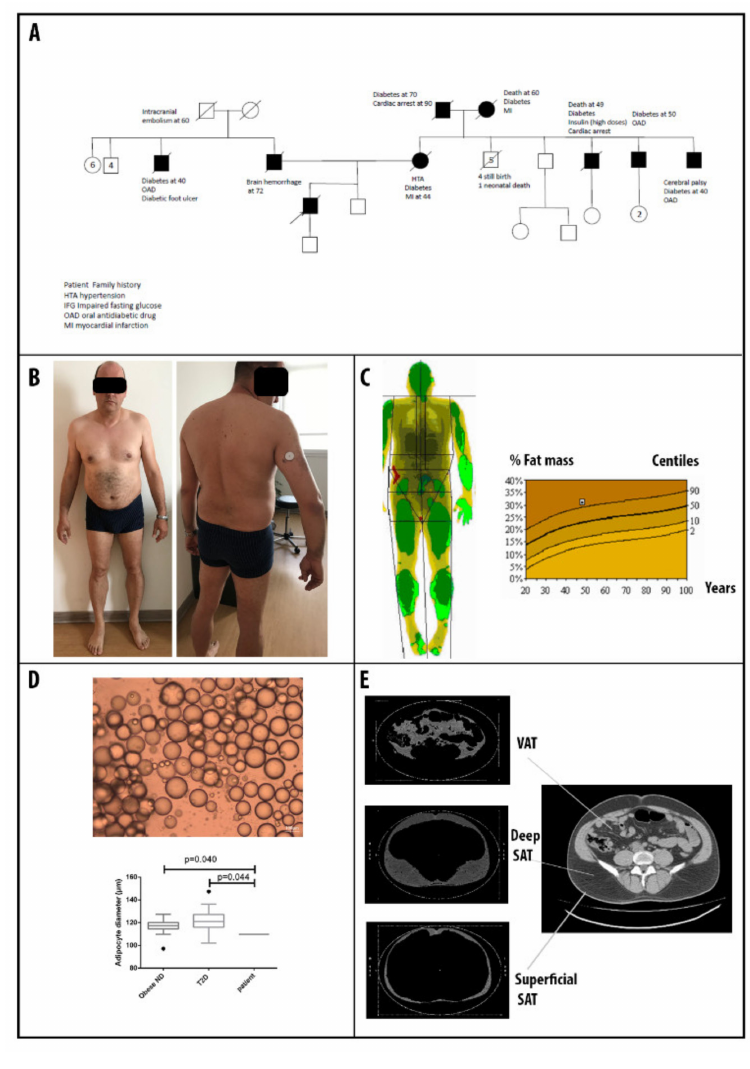
Figure 2. Patient 2 clinical description ( A ) Pedigree of patient 2 family. ( B ) Photographs of patient 2 showing no lower limb lipoatrophy but a high waist circumference. ( C ) DEXA showing body fat distribution and the moderate excess of fat mass (31.1%) compared to the reference curve. ( D ) Needle fat biopsy showing smaller adipocytes than a matched for age sex and BMI obese non-diabetic (ND) and a type 2 diabetic population. ( E ) Abdominal CT scan confirming the presence of an excess of deep subcutaneous